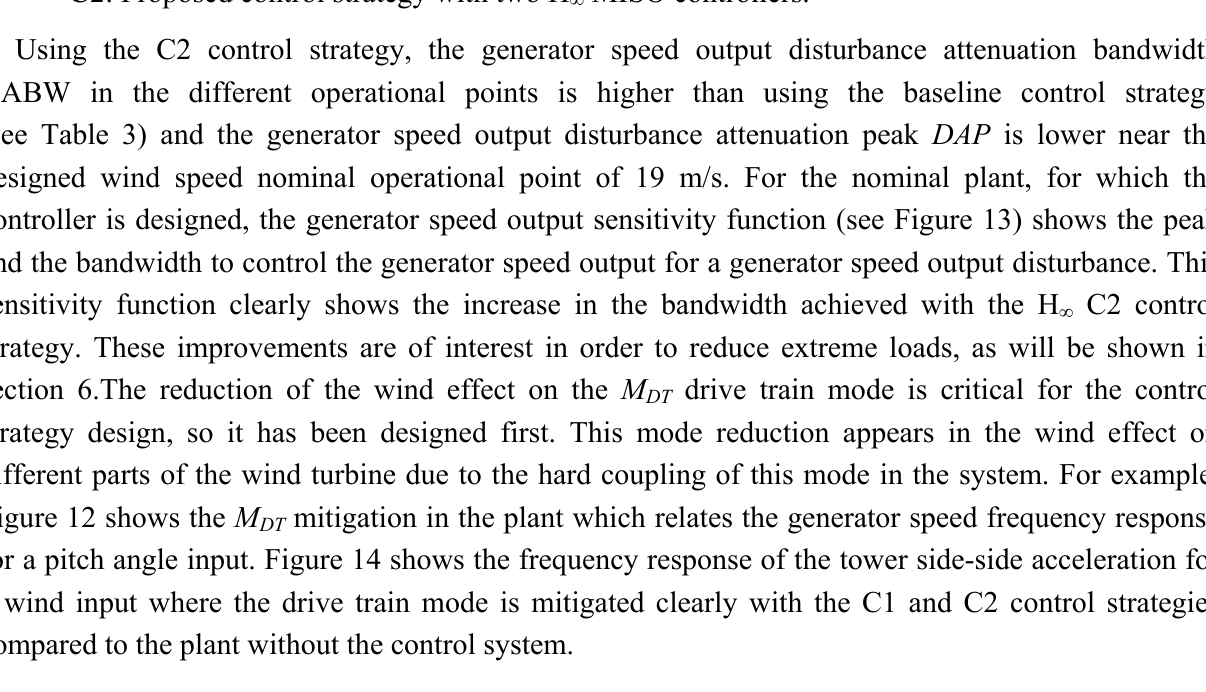
Table 3. Comparison of generator speed disturbance